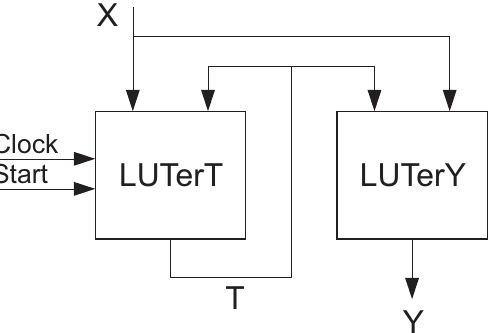
Figure 3. Structural diagram of LUT-based P Mealy